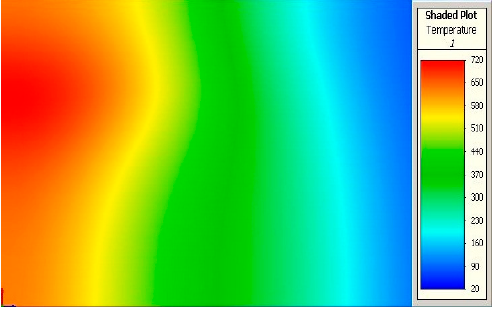
Figure 6. After optimization.